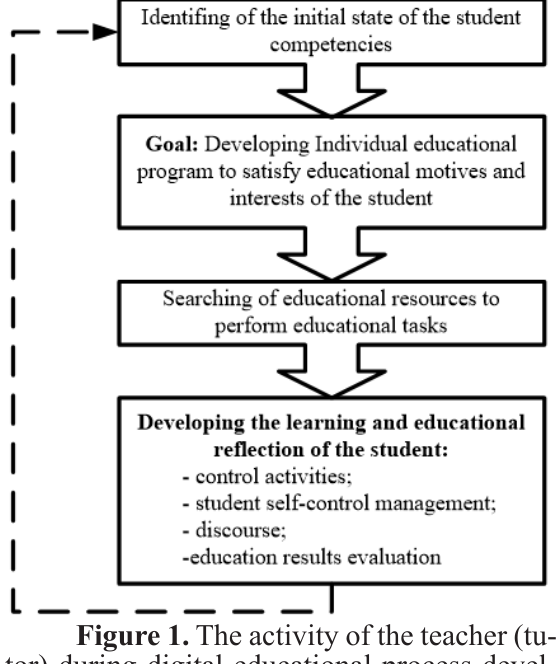
Figure 1. The activity of the teacher (tu- tor) during digital educational process devel-